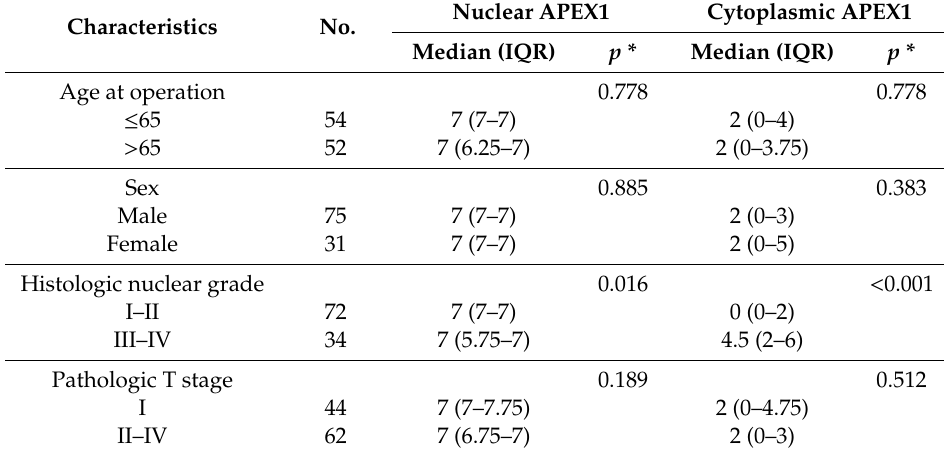
Table 2. Summary of the clinicopathologic characteristics of patients with primary clear cell renal cell carcinoma ( n =